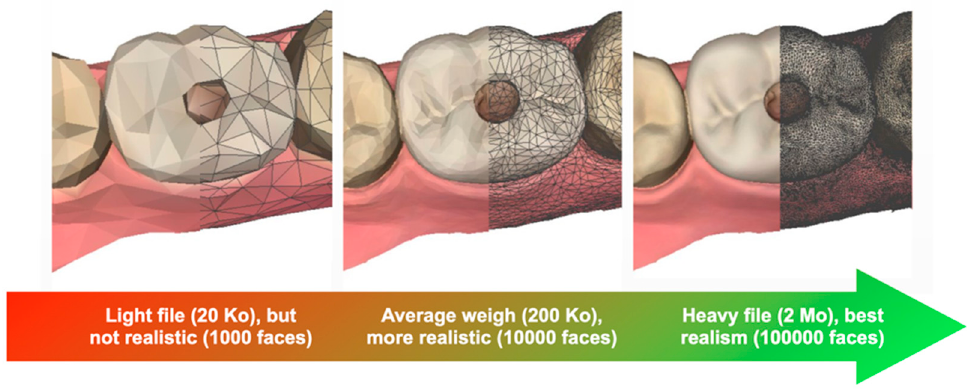
Figure 5. Impact of mesh density (number of faces) on file size and realism .